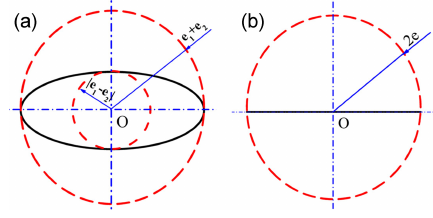
Figure 7. Motion curve of O 2 when ω 1 = − ω 2 . (a) e 1 (cid:54)= e 2 , (b) e 1 = e 2 = e